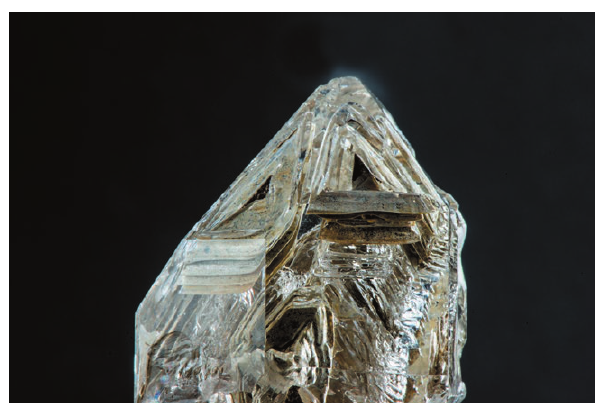
Fig. 10. Quartz: stepped crystal (https://sma.unibo.it/en/the-uni- versity-museum-network/mineralogical-collection-luigi-bombicci-